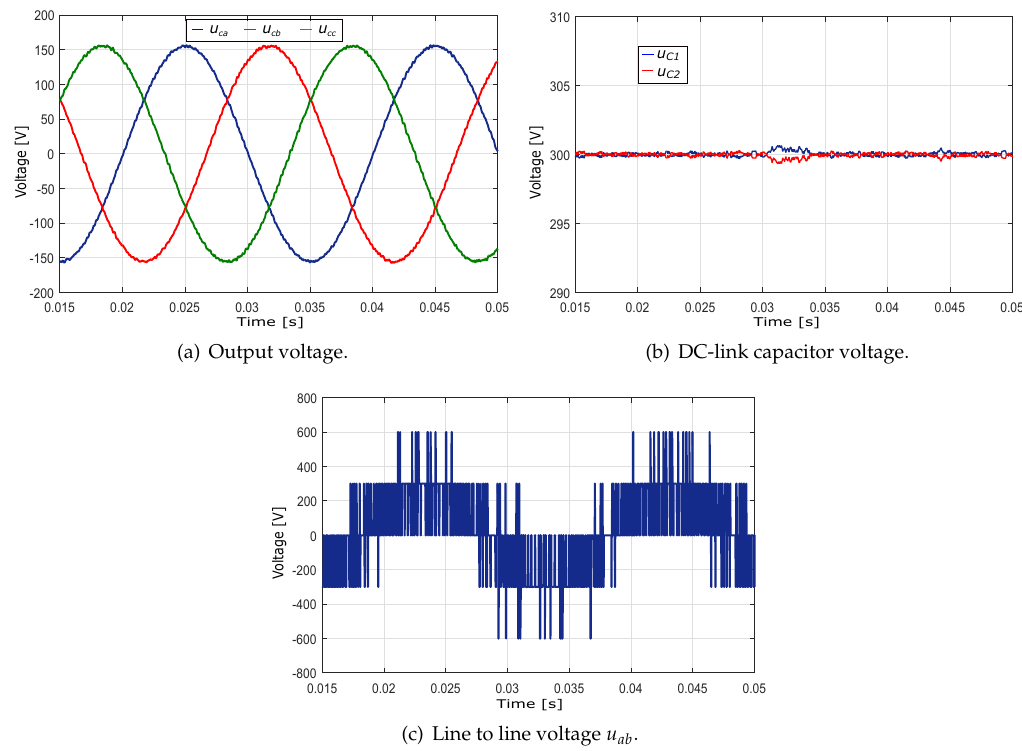
Figure 6. Steady-state of the proposed method at the output voltage of 155